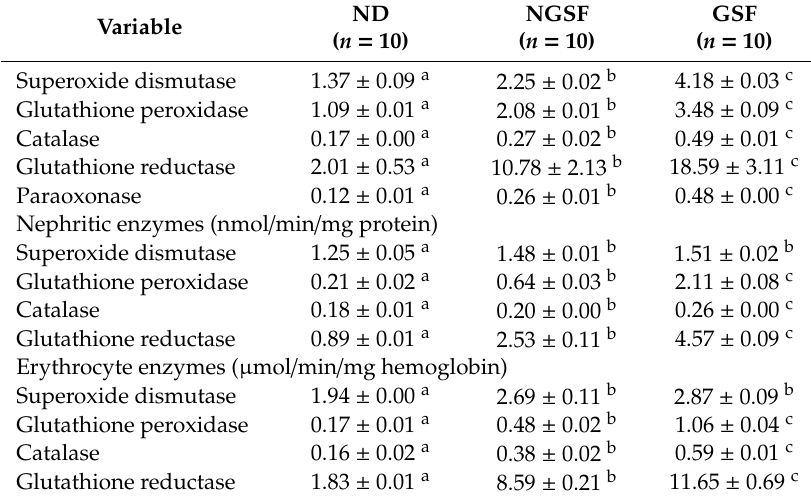
Table 5. Activities of antioxidant enzymes in ovariectomized rats fed with non-germinated Superjami rice flour or germinated Superjami rice